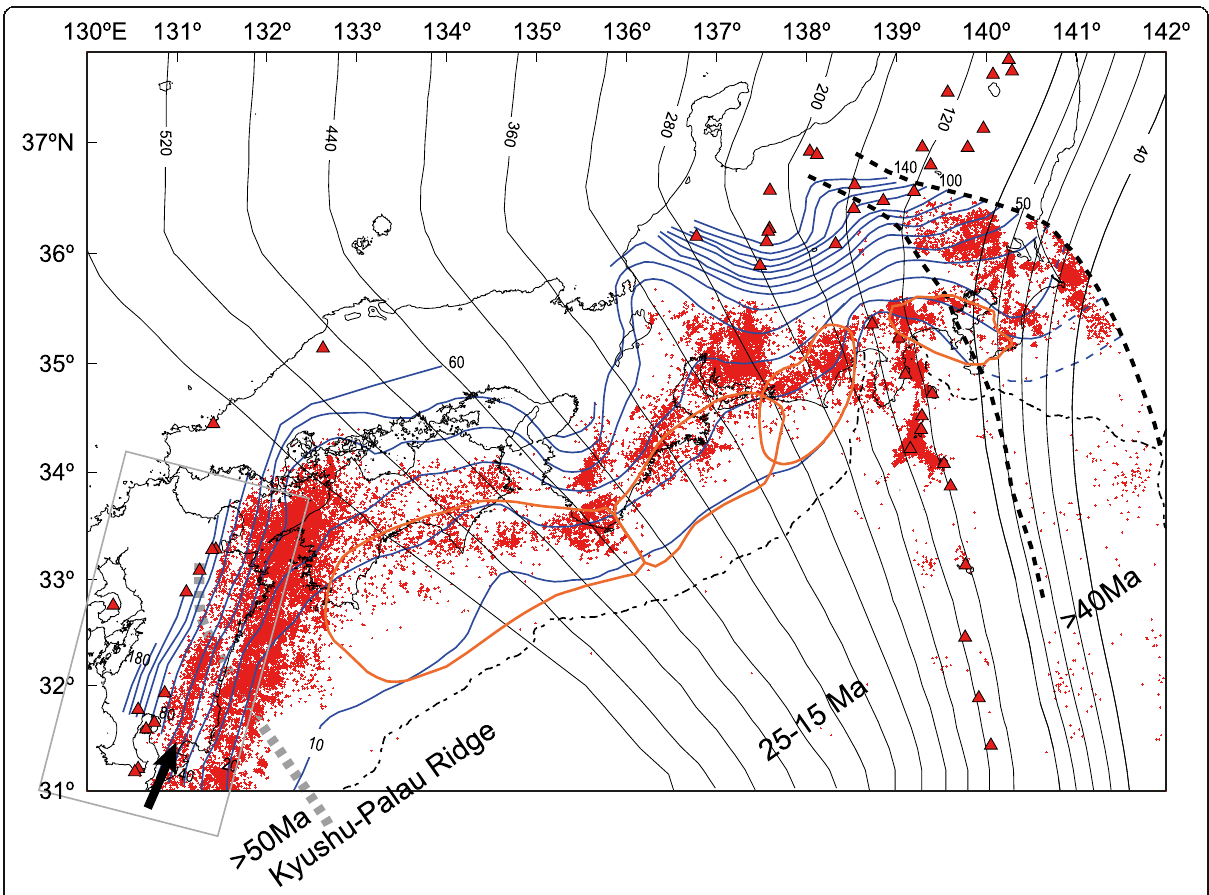
Fig. 12 Hypocenter distribution of earthquakes in the crust of the Philippine Sea plate under western Japan. Events 0 – 10 km below the upper plate surface are shown as red dots. Bold arrows denote estimated locations of the upper-plane seismic belt. The contact zone between the Philippine Sea and Pacific plates beneath Kanto is indicated by thick broken curves. Solid curves , red triangles , and orange curves denote iso-depth contours of the upper plate surface, active volcanoes, and source areas of large interplate earthquakes, respectively. Thick , broken gray line shows the Kyushu – Palau Ridge and its northeastern prolongation on top of the Philippine Sea slab. The northward bend near the northern end appears because of the projection of the slab ’ s top surface with an increasing subduction angle relative to Earth ’ s surface. (After Hasegawa et al.